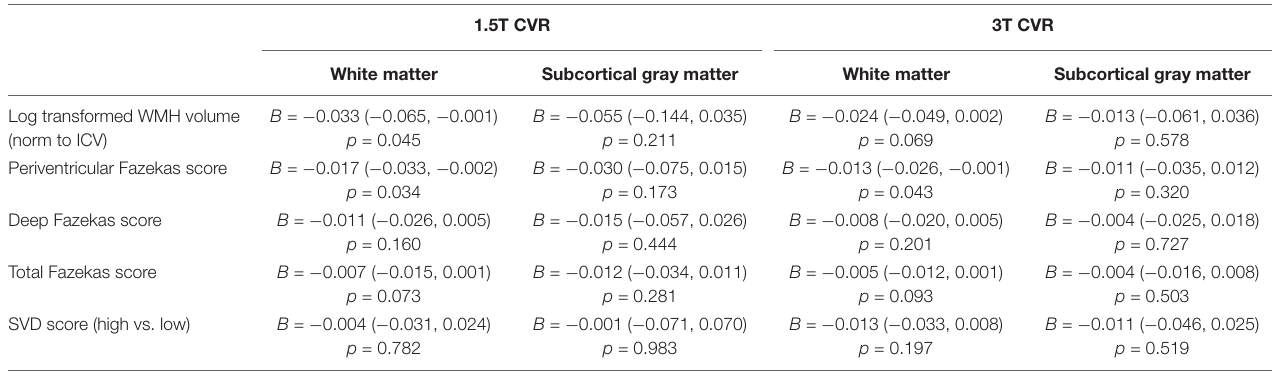
TABLE 3 | Associations of cerebrovascular reactivity (CVR) magnitude in subcortical gray and white matter at 1.5T and 3T with key SVD variables using multiple linear regression controlling for age, sex, and systolic blood pressure ( n =